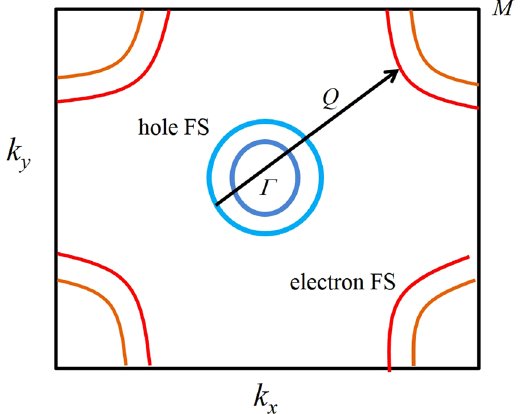
Figure 11. Schematic showing horizontal cut of Fermi surface in the tetragonal phase with relaxed z As ( = 0.353). In the primitive tetragonal unit cell, the M point corresponds to the X point of body centered tetragonal unit cell.